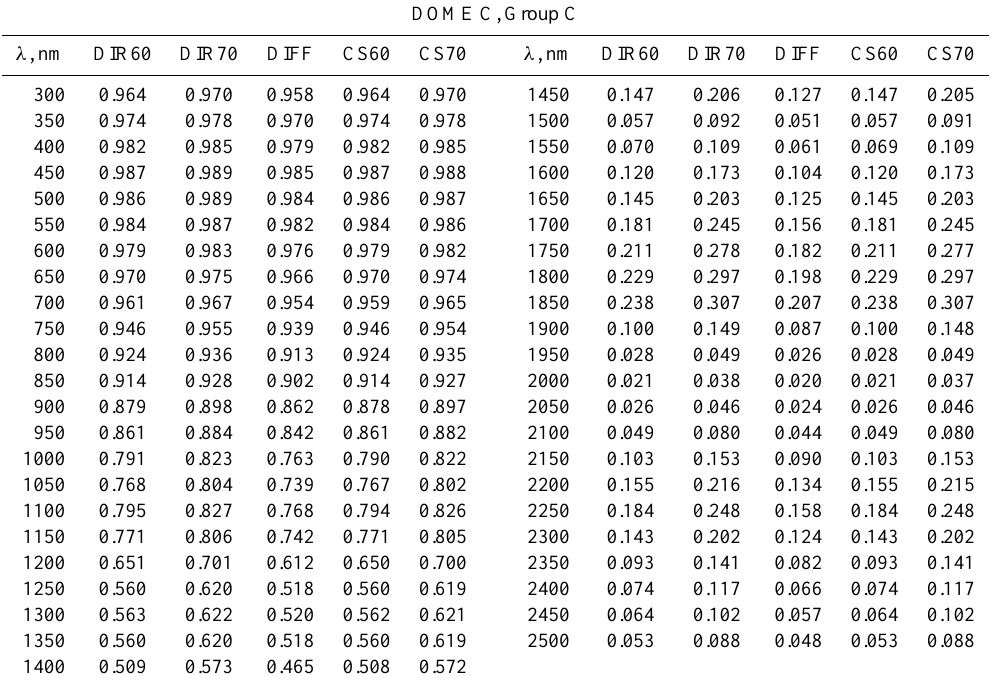
Table A3. Directional hemispherical reflectance of the mean of group C pits, at Dome C, calculated using the light sources of Table 2.